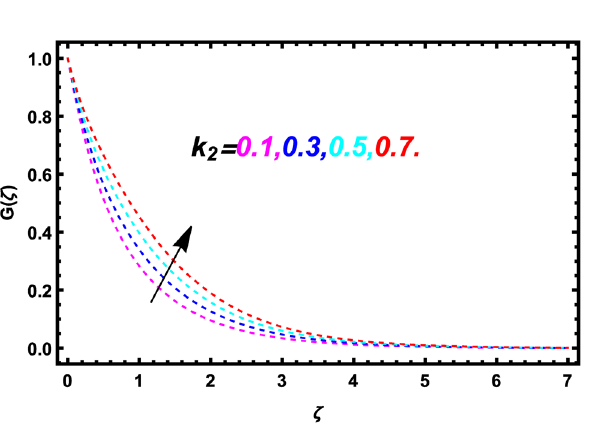
Figure 12. Demonstration of velocity curve versus k 2 when Fr = 0.2, k 1 = 0.1, M = 0.5, m = 0.2, Pr = 5.3, φ = 0.01, Ec = 0.3, ε Rd = 0.2, Sc = 0.1, ε Lb = 0.3, Pe = 0.3. t = 3.0, C = 3.0, δ = 0.3,